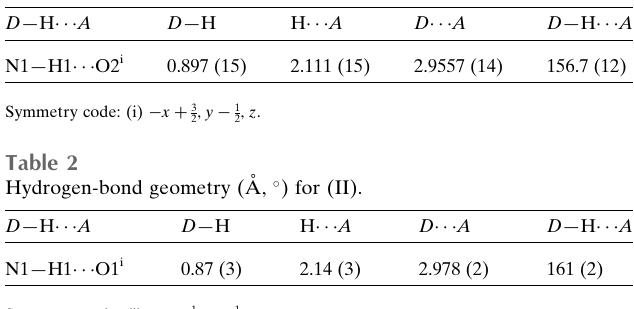
Table 1 Hydrogen-bond geometry (A˚ , (cid:2) ) for (I).